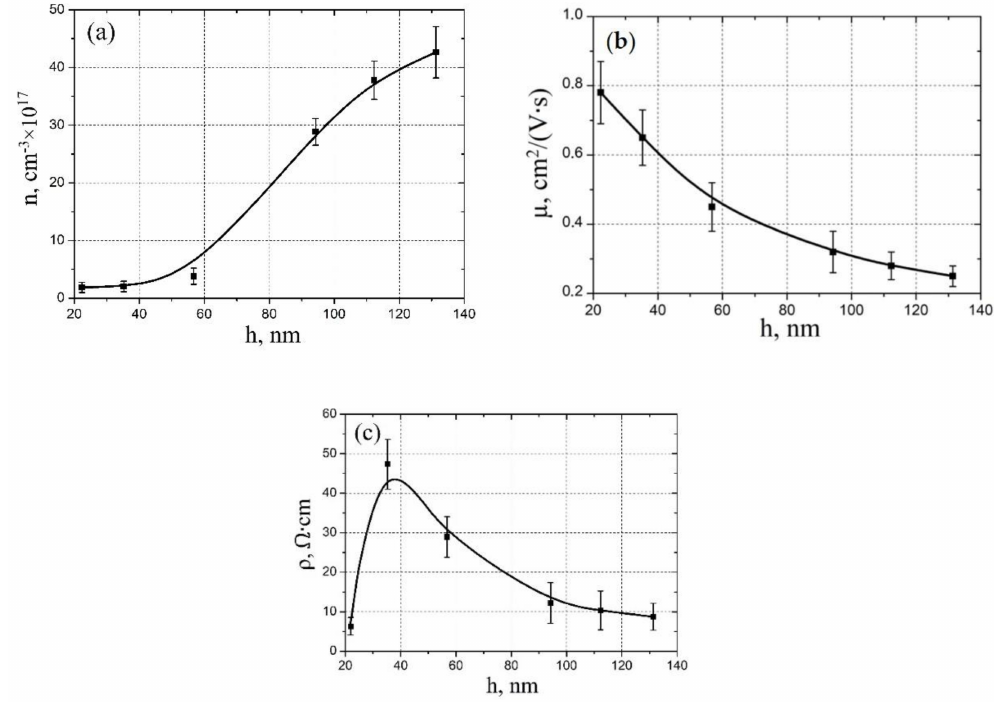
Figure 3. Experimental study electrophysical parameters dependence on vanadium oxide film thickness: ( a )—electron concentration; ( b )—electron mobility; ( c